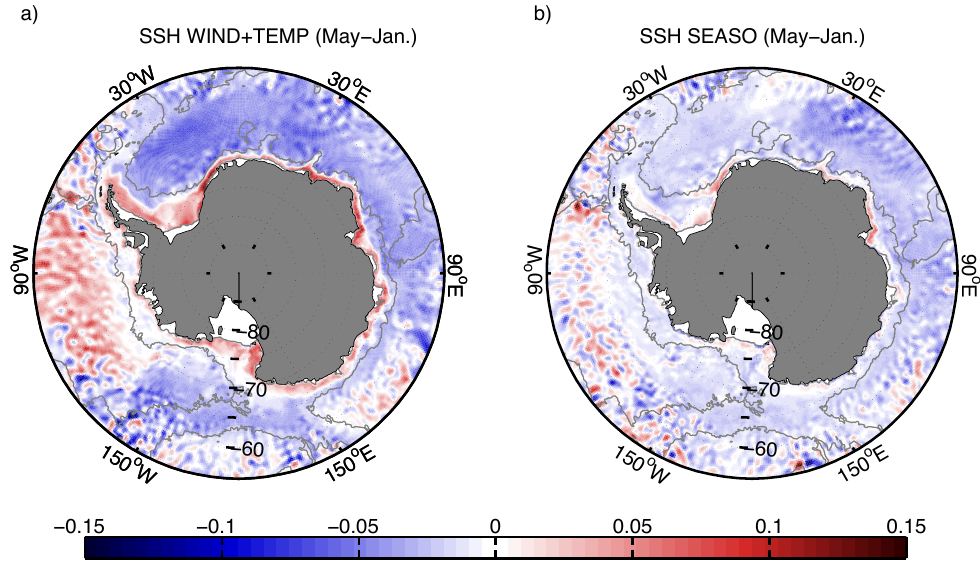
Fig. 15. SSH difference (in m) between May and January in WIND + TEMP (a) and in SEASO simulations (b) . A red area means a higher SSH in May. Grey line corresponds to the 3500m bathymetry